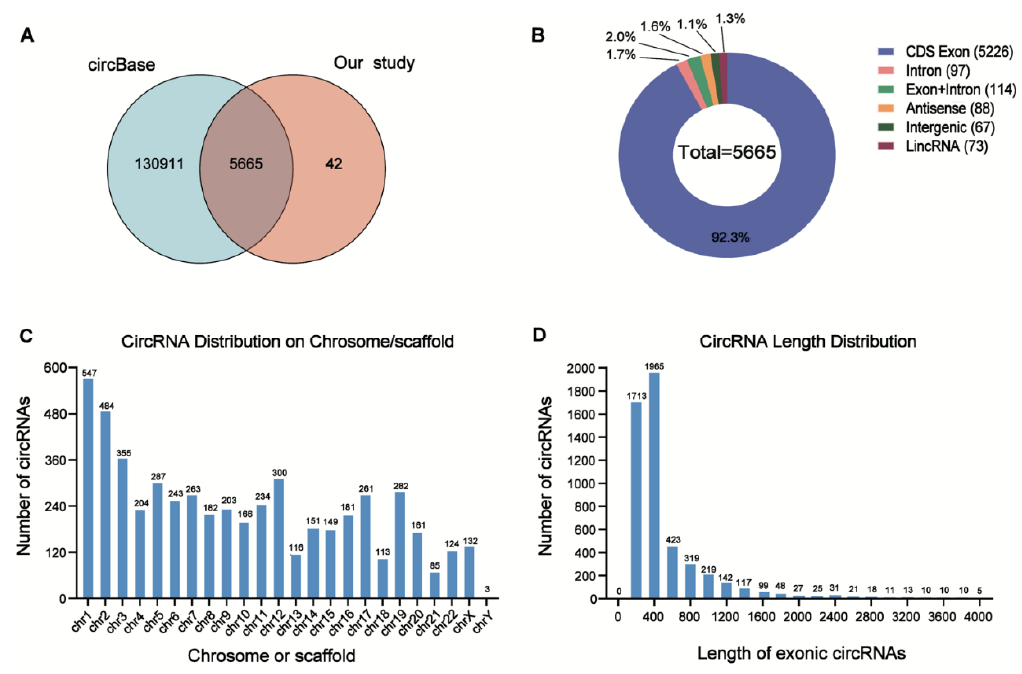
Figure 3. Overview of the DE circRNAs in AML patients with relapse (RE) and controls (CR or HC). ( A ) Overlapping of identified circRNAs between circBase and our study. ( B ) Genomic origin of the circRNAs identified in the relapsed samples and controls. ( C ) The chromosome distributions of exonic circRNAs. ( D ) The length distributions of exonic circRNAs.